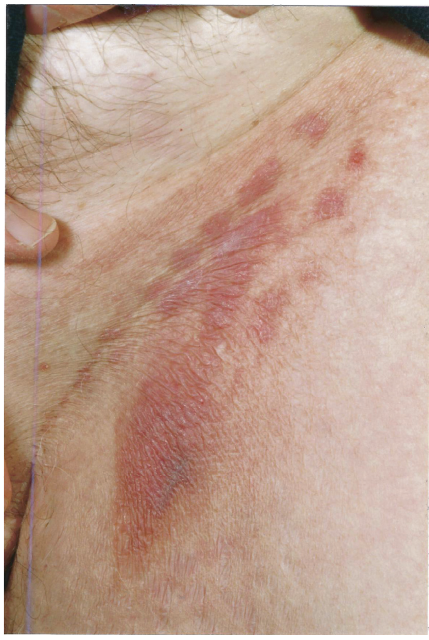
Figure 1: Multiple plaques of mycosis fungoides in the skin of the left inguinal region.